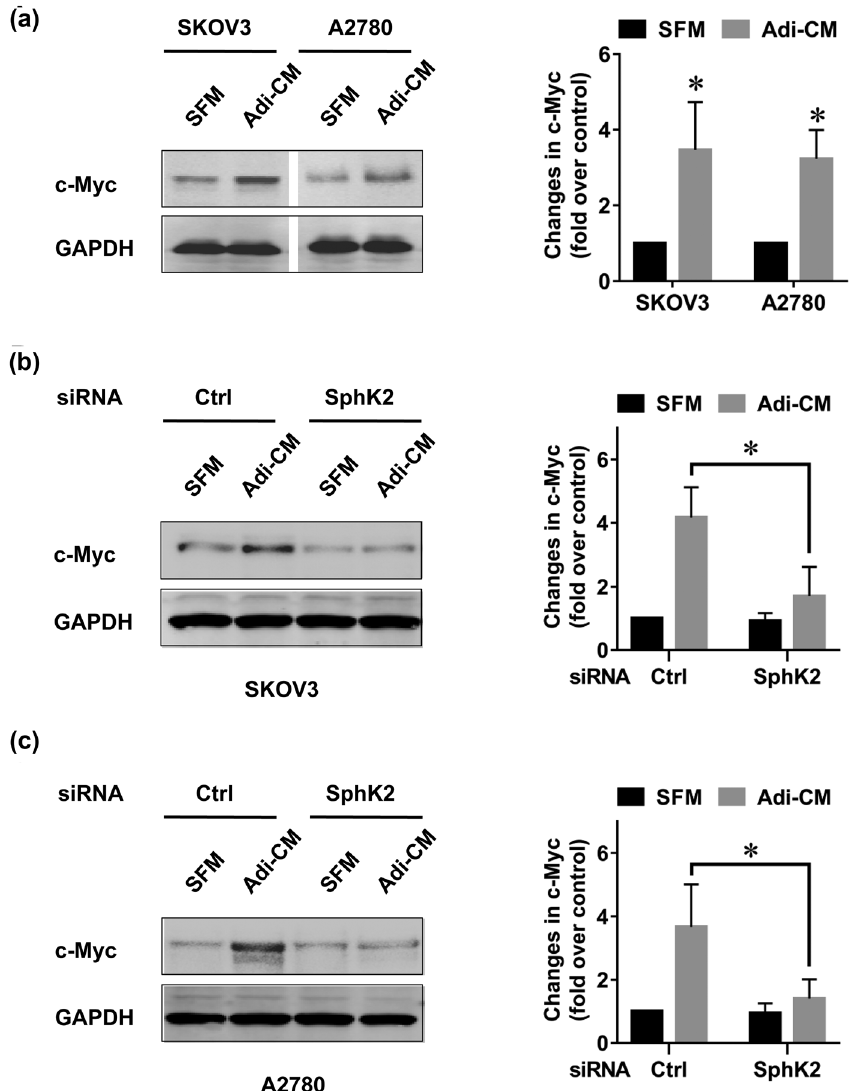
Figure 4: Adipocyte - induced c - Myc expression is partly SphK2 dependent. ( a ) SKOV3 and A2780 cells were cultured with SFM or Adi - CM for 24 h. c - Myc expression level was determined by using Western blot. Densitometric analysis of c - Myc is shown on the right. ( b ) SKOV3 and ( c ) A2780 cells were transfected with the indicated siRNAs and cultured with SFM or Adi - CM for 24 h. c - Myc levels were then determined by using Western blot. Right panel shows the densitometric analysis of c - Myc. Molecular weight of c - Myc is 57 kDa and molecular weight of GAPDH is 36 kDa. Data are the mean ± SD. *, P <